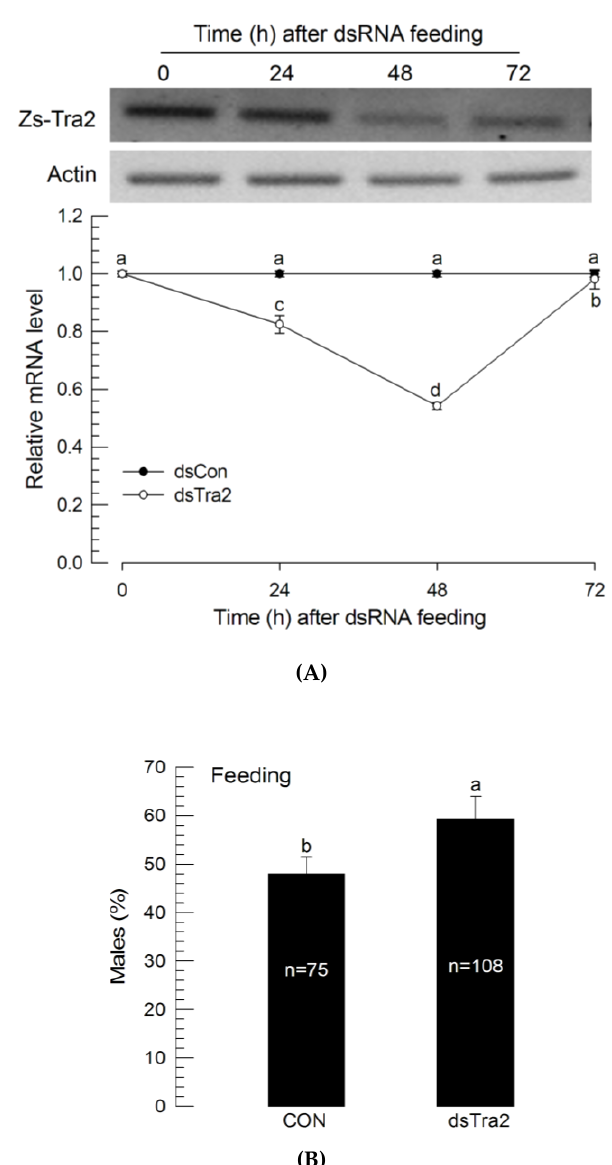
Figure 4. Influence of dsRNA (‘dsTra2’) specific to Zs-Tra2 on male-biased adult production in Z. scutellata . RNAi was performed by feeding dsRNA (10 μg) mixed with diet (500 mg) to newly molted L1 larvae (< 12 h) for 48 h. For dsRNA control (‘dsCon’), dsRNA specific to CpBV-ORF302 was prepared by the method of Park and Kim [24]. ( A ) RNAi efficiency assessed by RT-qPCR. Actin gene expression was used as a reference gene of RT-qPCR to normalize target gene expression level. Each treatment was replicated with independently prepared samples. ( B ) Outcome was assessed in ratio of male adults. Number indicates the number of assessed adults. Different letters above standard deviation bars indicate significant difference among means at Type I error = 0.05 (LSD test).